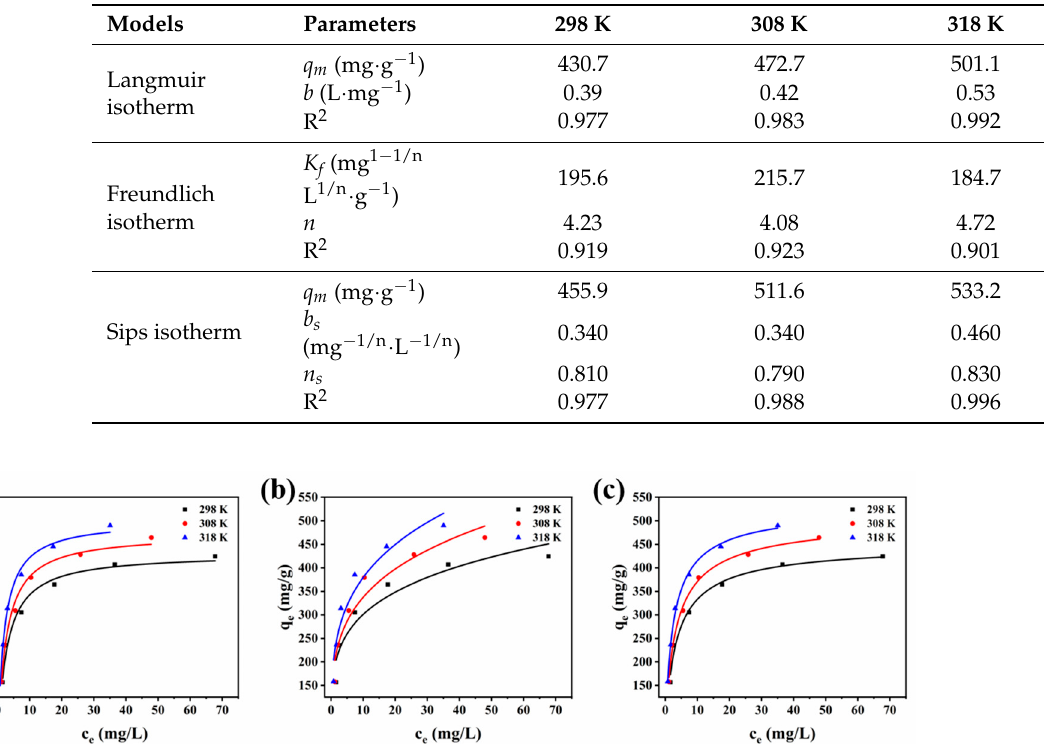
Table 2. Parameters and correlation coefficients for the adsorption of TC on MOF-525/GO.